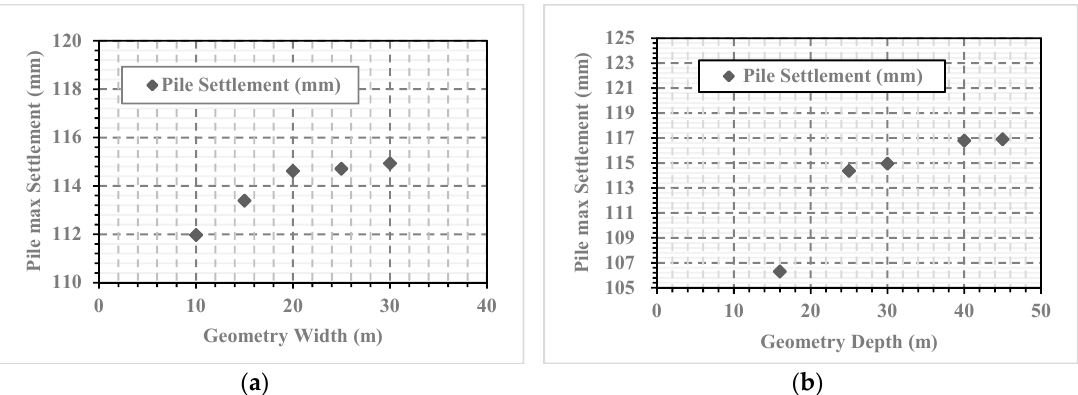
Figure 8. Relations between maximum obtained pile settlement and model geometry. ( a ) Model geometry width. ( b ) Model geometry depth.